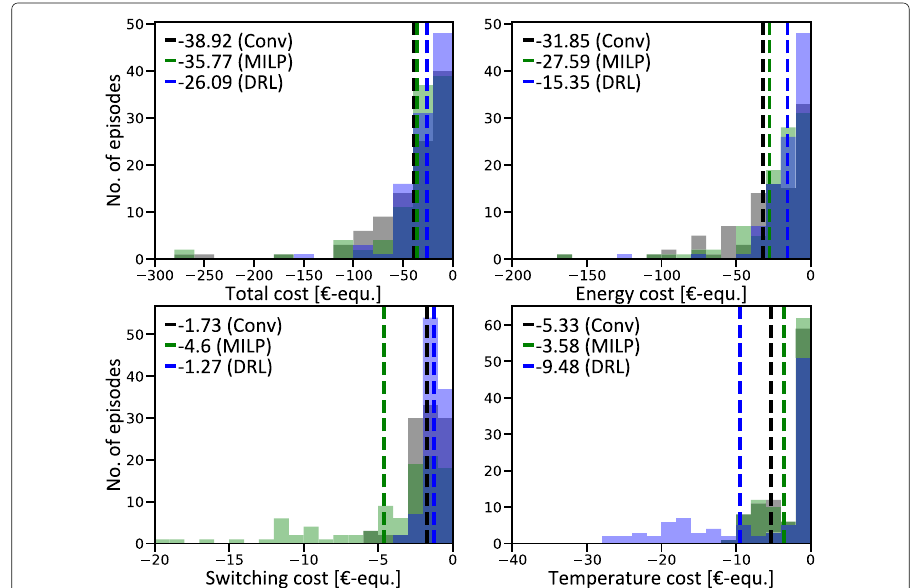
Fig. 7 Distribution and mean value of overall and specific cost per episode for system A . Cost in this case are interpreted as negative rewards, thus increasing performance is indicated by higher values. Black: Conventional controller, Blue: DRL controller, Green: MILP